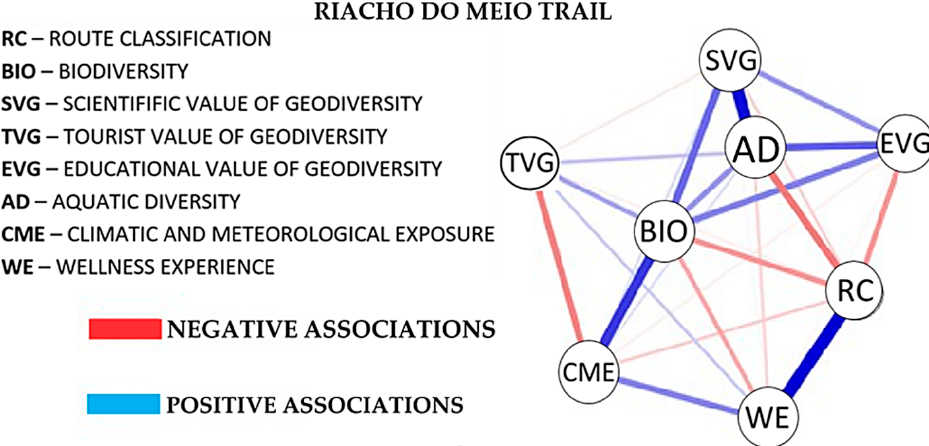
Figure 16. Network Ecosystem’s Health Provision Spectrum of the Riacho do Meio trail.